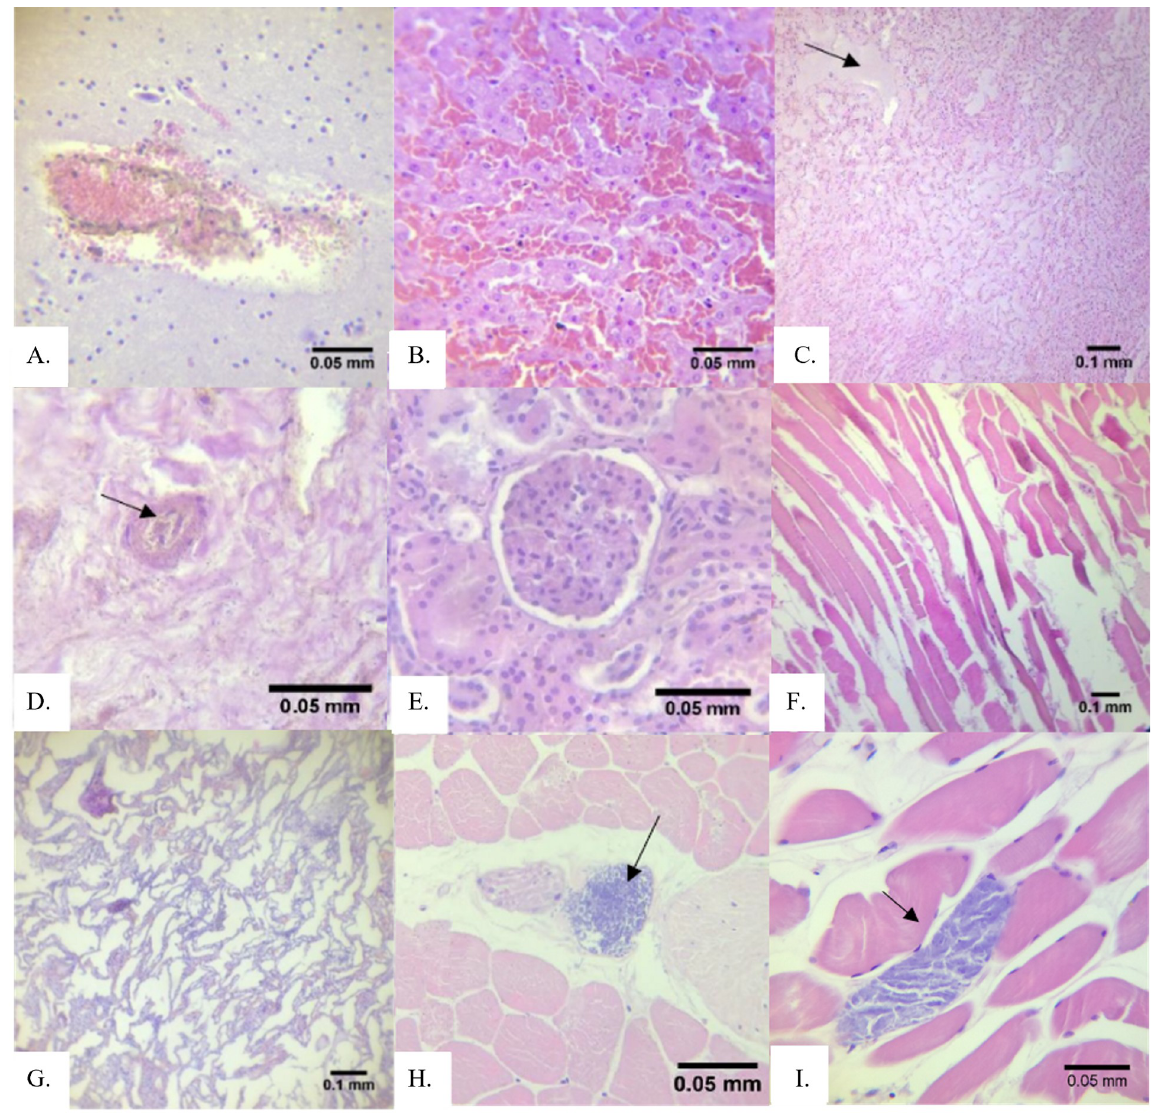
Fig 2. Histopathological lesions observed in tissues of 21 cetaceans that stranded in the Philippines (2017–2018). (A) hemorrhage in S03 kidney; (B) severe congestion in S11 liver; (C) edema in S12 liver; (D) hemosiderosis characterized by the presence of brown granular pigments in S05 kidney; (E) glomerulopathy in S14 kidney; (F) Zenker’s necrosis characterized by hyaline degeneration, loss of striations, and muscle fiber waviness in S06 skeletal muscle; (G) atelectasis (collapsed alveoli) in S10 lungs; (H) unidentified cyst in skeletal muscle of S14; and (I) putative Sarcocystis cyst in skeletal muscle of